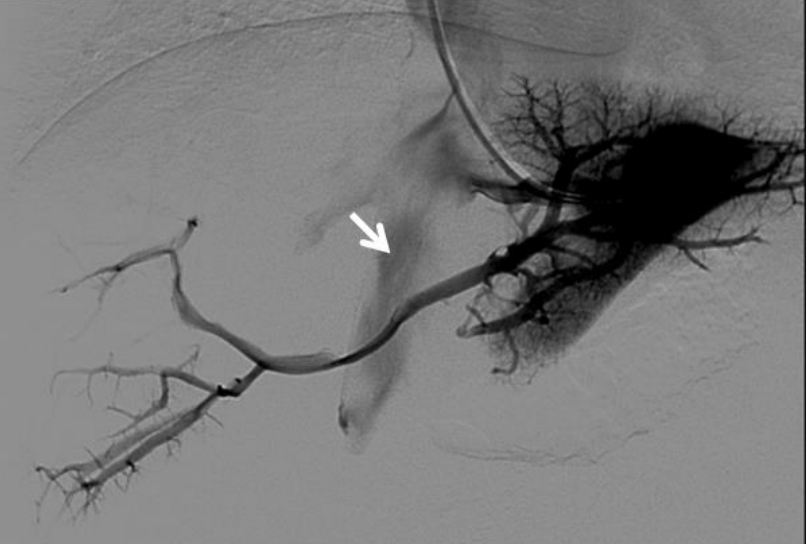
Figure 8. Right oblique anterior (30° cranial) view of a transjugular retrograde portography per- formed in a 9-year-old female with extrahepatic portal vein cavernoma due to a neonatal umbilical vein catheterization and portal vein thrombosis, who complained of symptoms of portal hyperten- sion. She was a candidate for Meso-Rex bypass surgery. The image shows retrograde filling of the intrahepatic portal vessels with the complete visualization of the Rex segment (arrow) after wedged left hepatic venography. Meso-Rex bypass was then surgically performed.